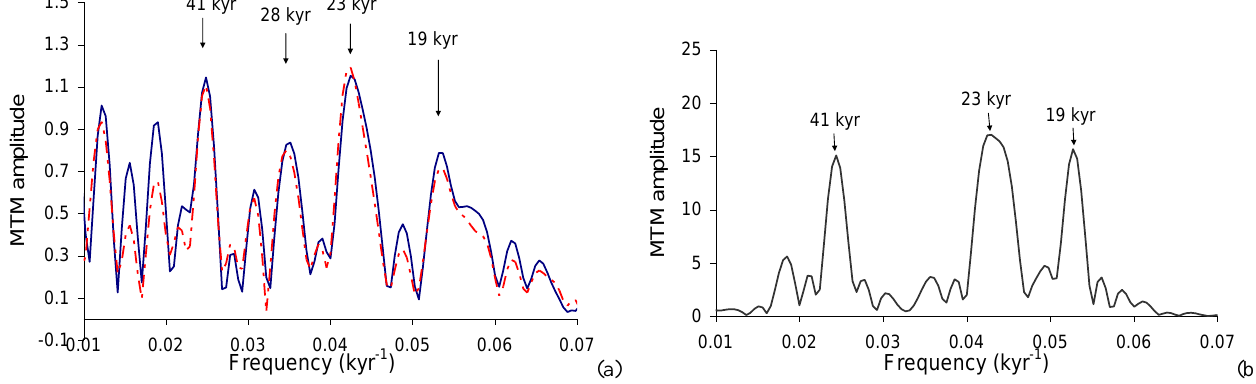
Fig. 4. (a) Spectral analysis (Multi-Taper Method) of the δ O 2 /N 2 composite curves (gas loss correction 1 in red and gas loss correction 2 in blue). The significant peaks ( > 90%) are identified with an arrow on top. (b) Spectral analysis (Multi-Taper Method) of the insolation curve (21 December insolation at 75 ◦ S). The significant peaks ( > 90%) are identified with an arrow on